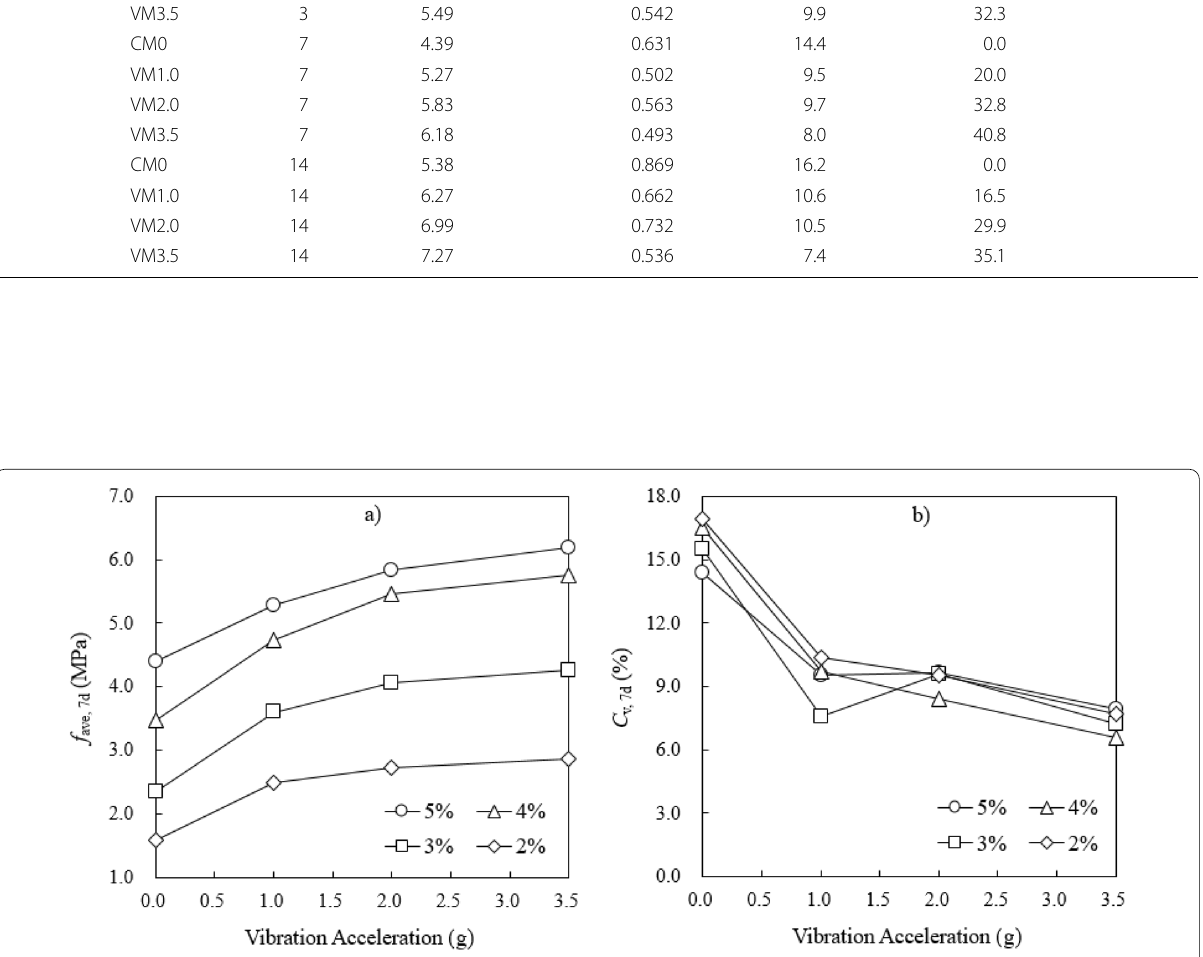
Fig. 4 7-Day UCS versus vibration acceleration for CSM with different cement dosage. a 7-day UCS; b coefficient of variation of